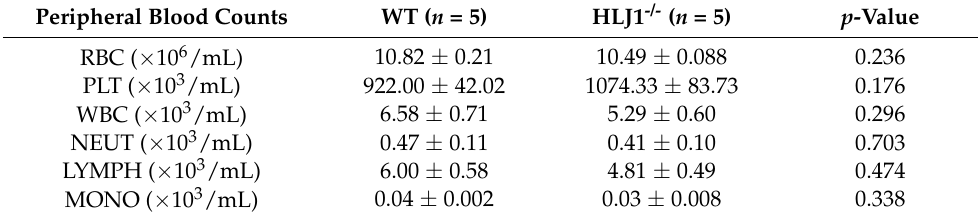
Table 2. Peripheral blood counts of WT and HLJ1 -/- mice.